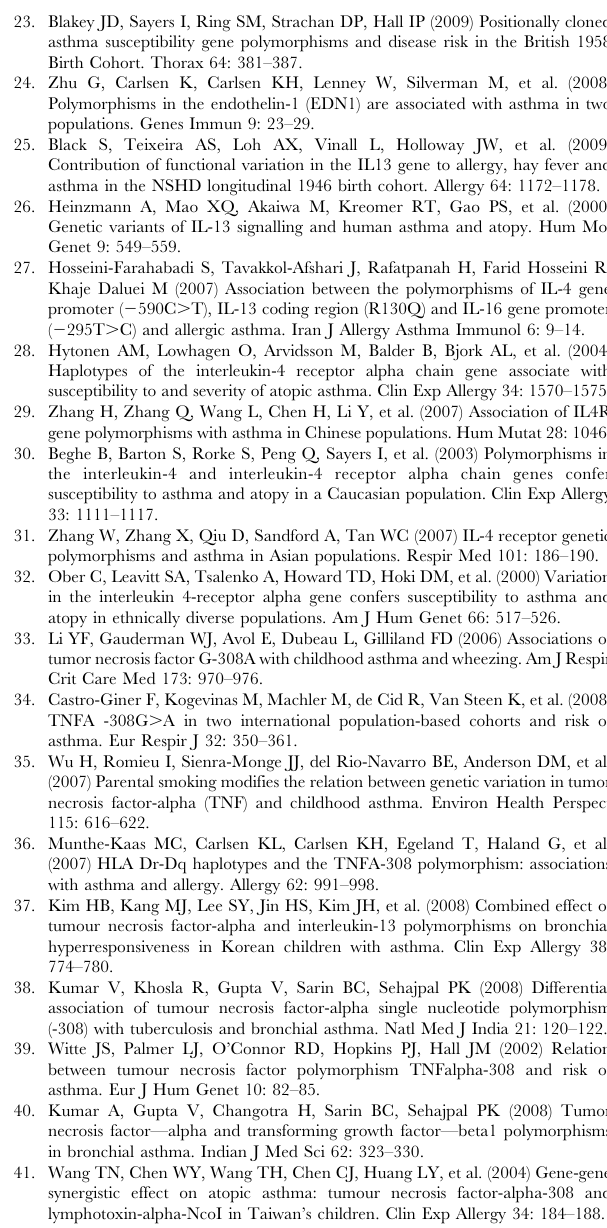
Table S3 Comparison of candidate gene SNP coverage by GWAS genotyping systems. Number of genotyped SNPs per candidate gene locus from 5 kb upstream of 1st exon to 5 kb after